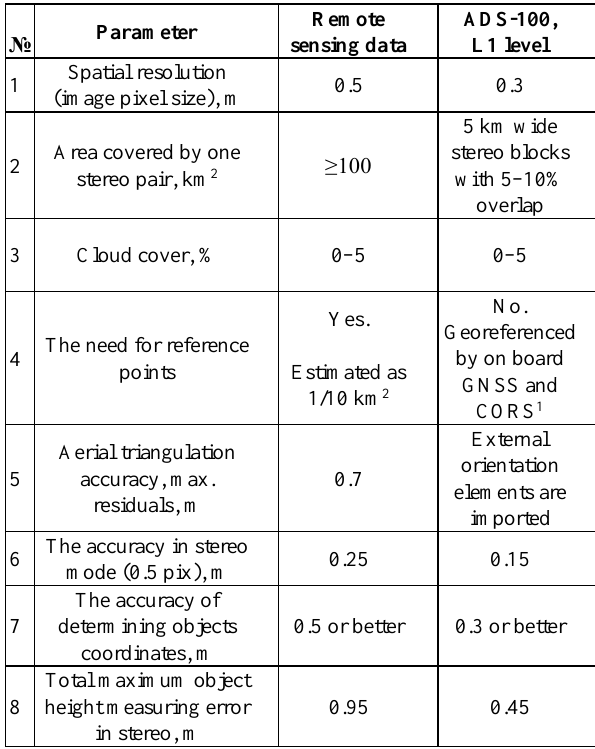
Table 1. Stereo images technical parameters